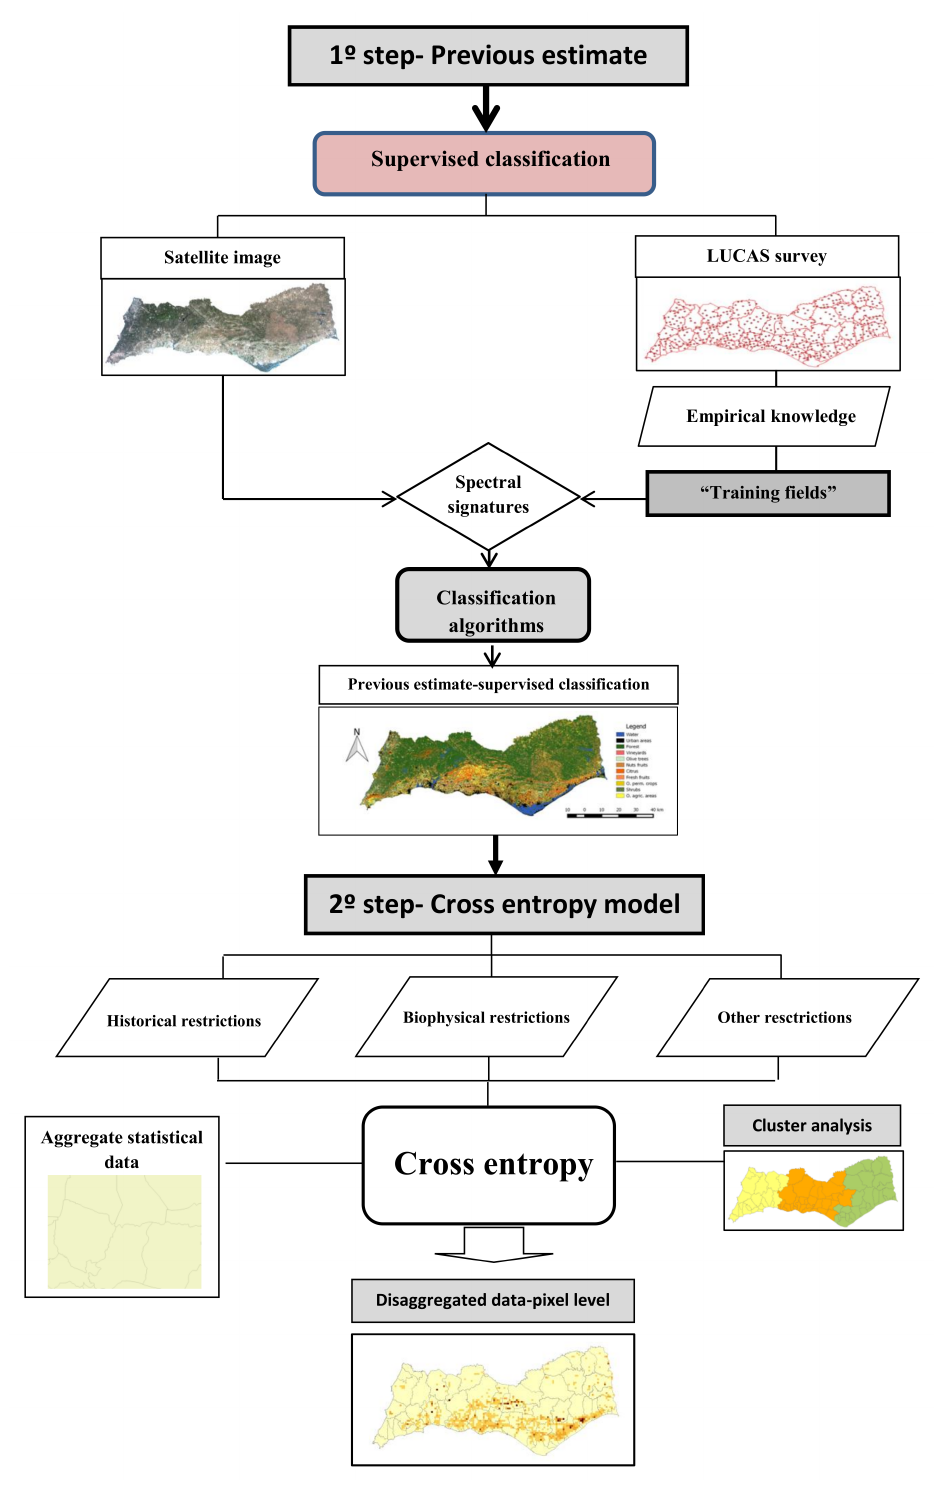
Figure 1. The methodological